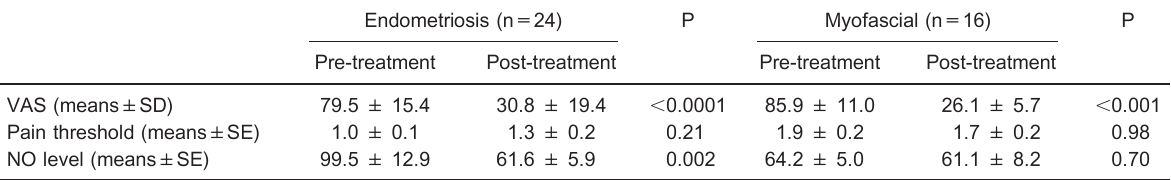
Table 2. Intensity of pain, pain threshold and nitric oxide levels after treatment for both the endometriosis and myofascial